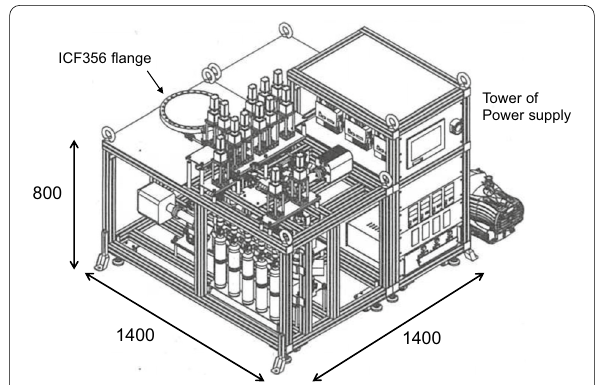
Fig. 5 External view of the GAEA. The numbers are the dimensions in millimeters